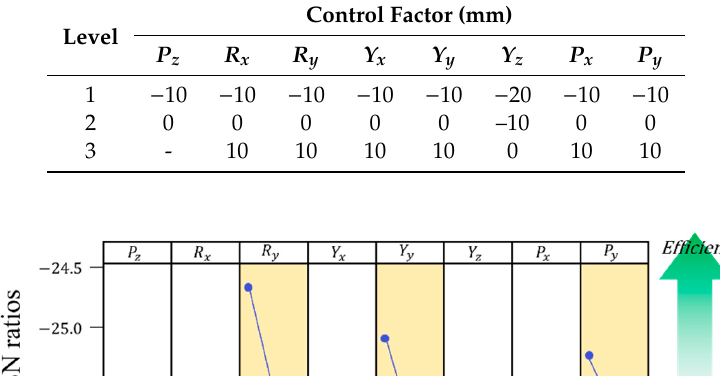
Table 1. Levels of control factors for the first experimental set.